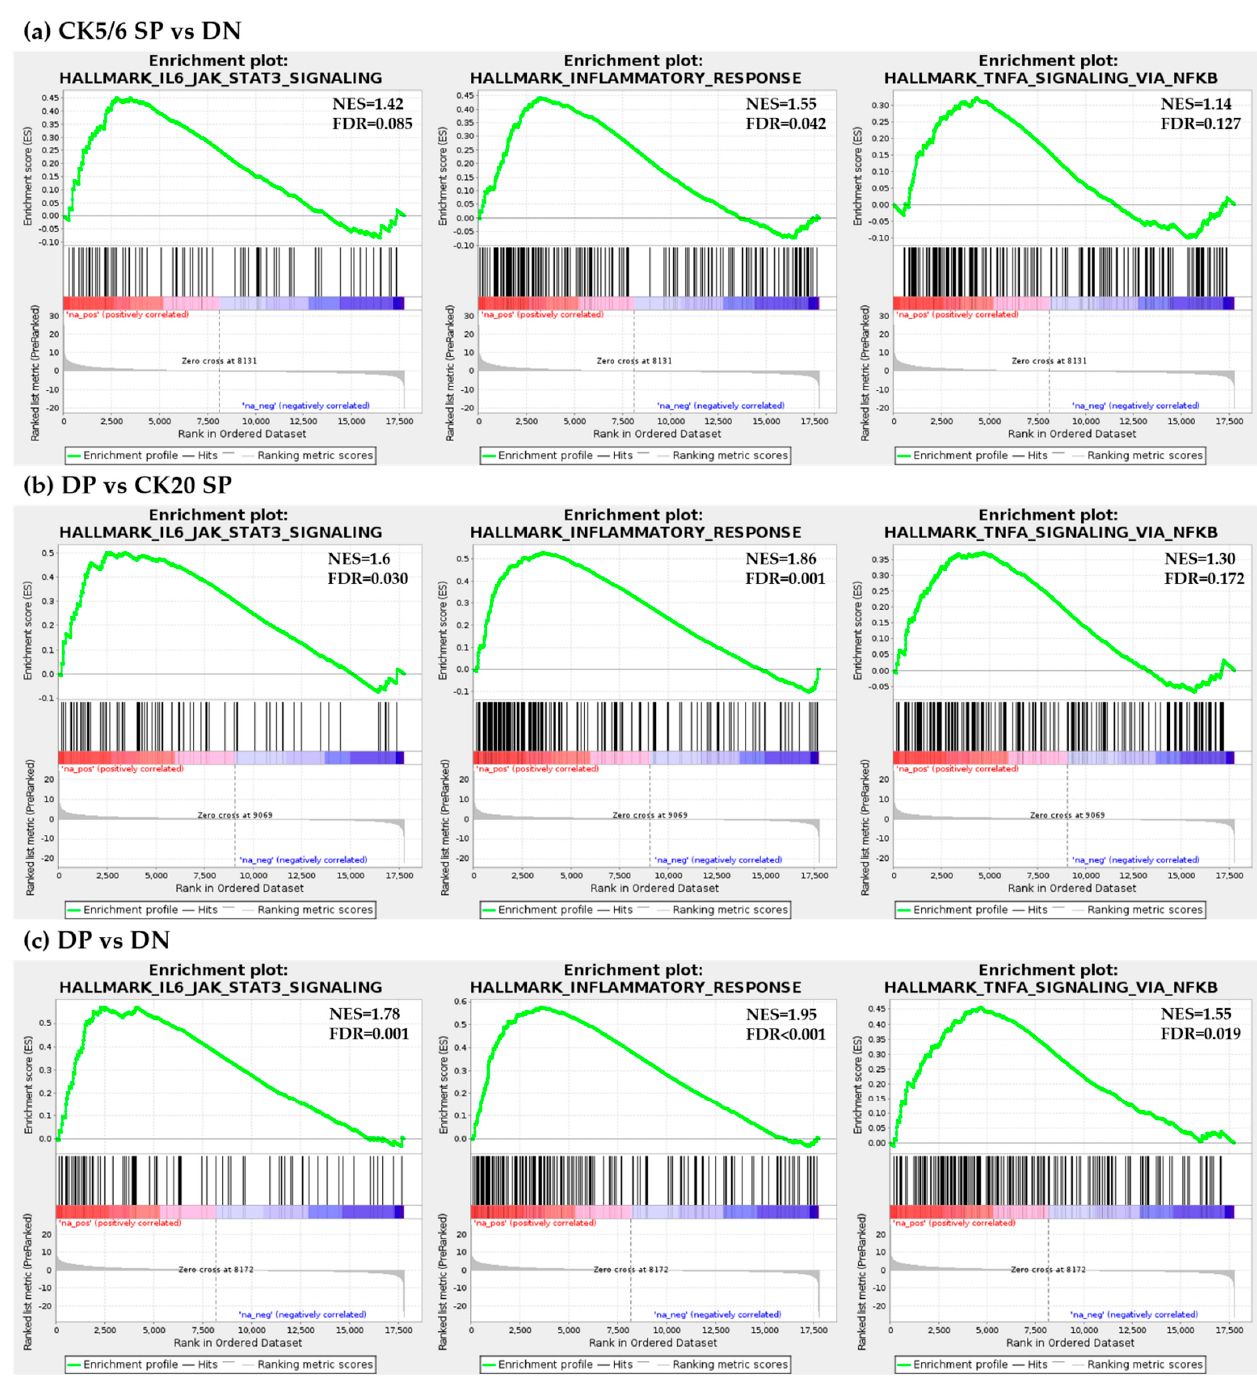
Figure 4. Gene set enrichment analysis results: ( a ) CK5/6 SP vs. DN; ( b ) DP vs. CK20 SP; ( c ) DP vs. DN.